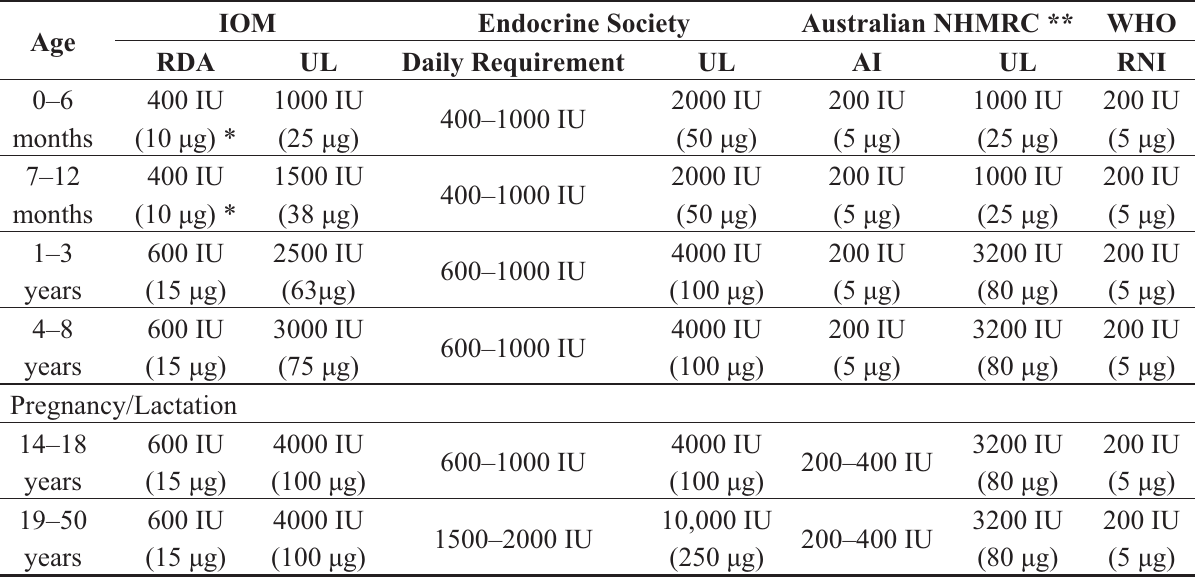
Table 2. Vitamin D recommended